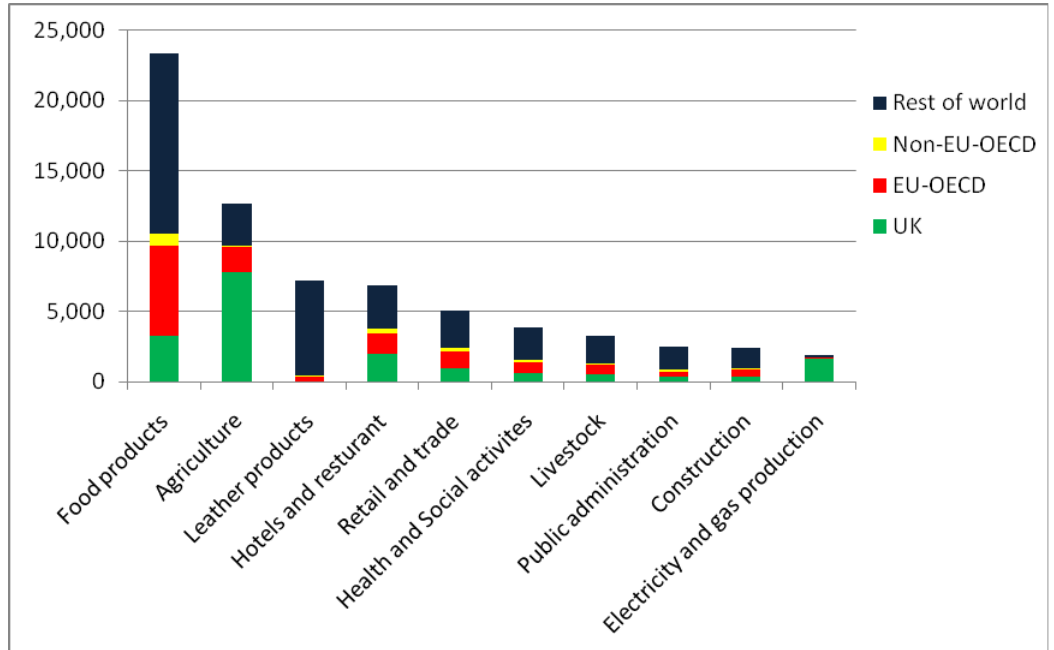
Figure 2. Top ten largest global water consuming sectors in the UK (million m 3